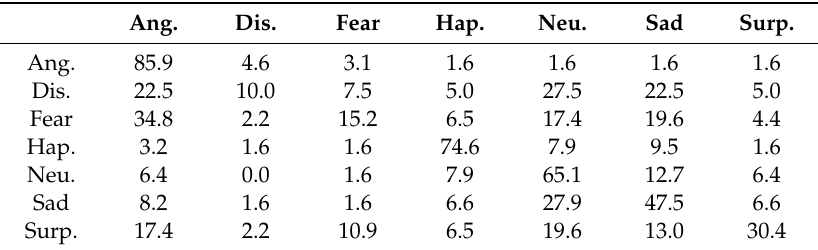
Table 11. The confusion matrix of VSHNN-LRMAF for AFEW dataset. Ang. Dis.